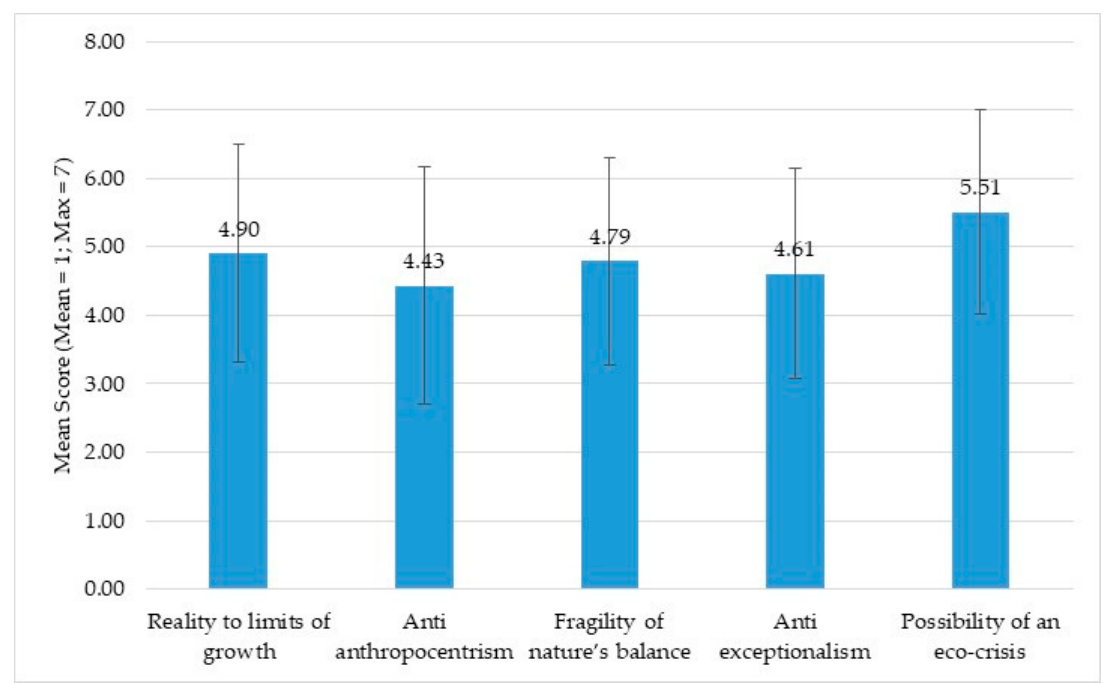
Figure 4. Mean scores and standard deviation for the five New Environmental Paradigm (NEP) subscales.